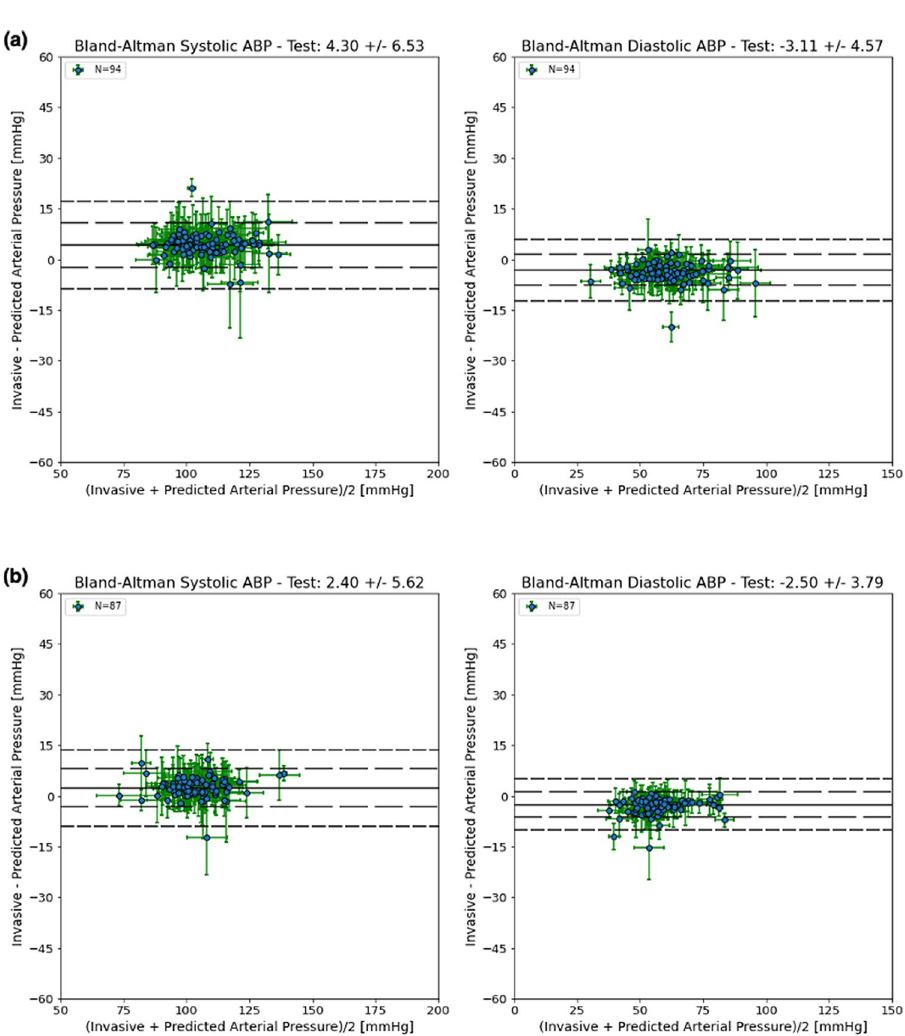
Figure 3. Bland–Altman plots for the MIMIC and UCLA ICU test cohorts. Systolic BP measurements per patient (left), and Diastolic BP measurements per patient (right) using a thirty-two second window; horizontal error bars represent the standard deviation of the blood pressure values, vertical error bars represent the standard deviation of the differences; solid lines indicate the mean difference values, dashed lines indicate the mean difference values +/− 1 and 2 times the standard deviation of the differences. Results for MIMIC are shown in ( a ), and UCLA in ( b